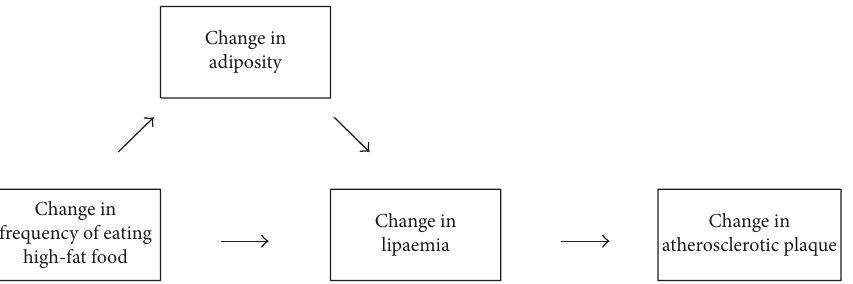
Figure 1: Behavioural model of influence of higher fat food consumption on adiposity and atherogenic